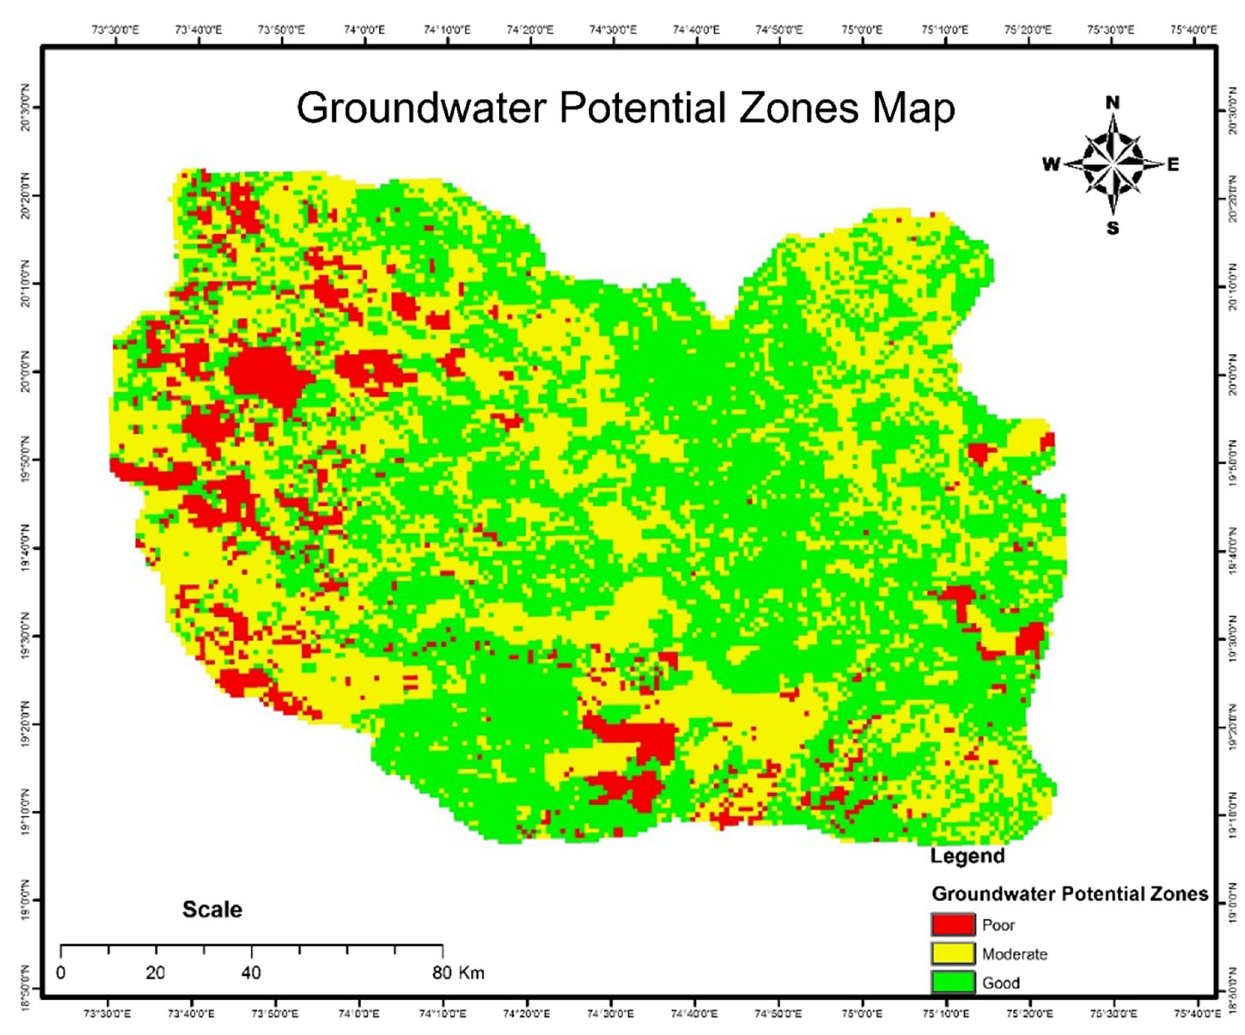
Fig. 4 Groundwater potential zone